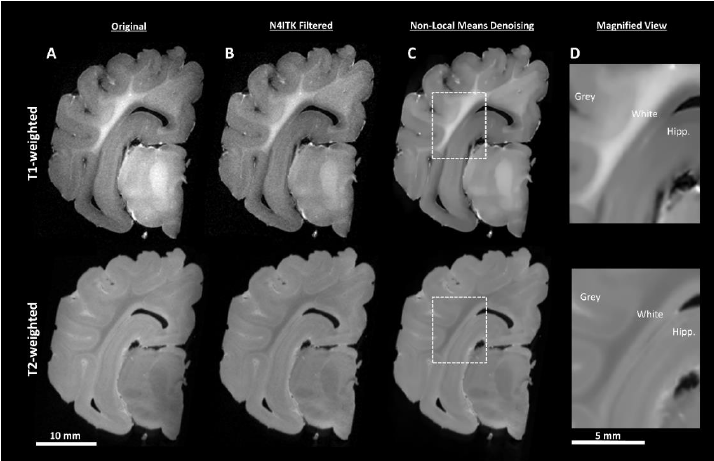
Figure 3. Image pre-processing demonstrated by T1- and T2-weighted coronal sections ( A ). N4ITK bias field correction ( B ) removes bright and dark patches in the image resulting in more uniform tissue-type intensity. The use of non-local means denoising ( C ) attenuates the high-frequency noise in the image, creating more uniform tissue boundaries. A magnified view of the boxed regions is shown in ( D ) encapsulating part of the cortex (White and Grey) and hippocampus (Hipp.) All images within each have normalized histograms to allow for quality comparisons.